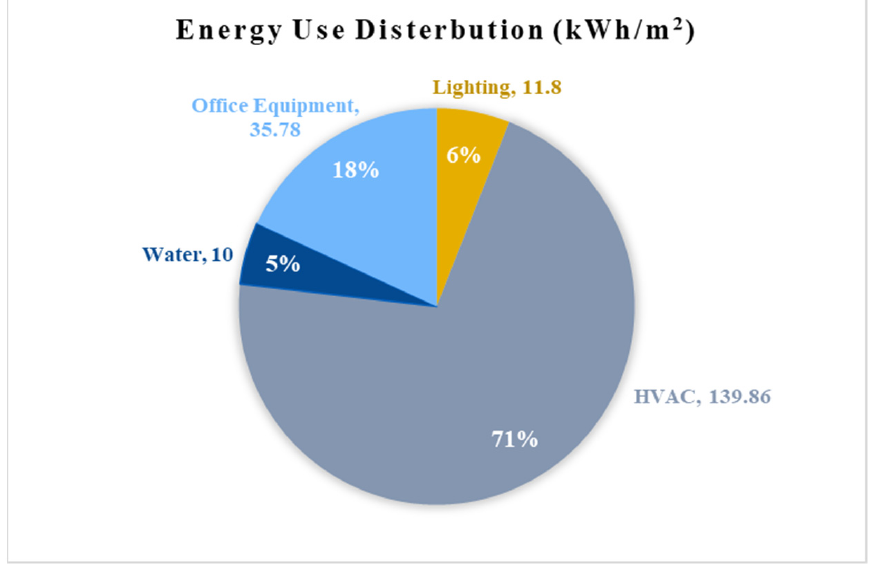
Figure 4. Baseline model energy use distribution.